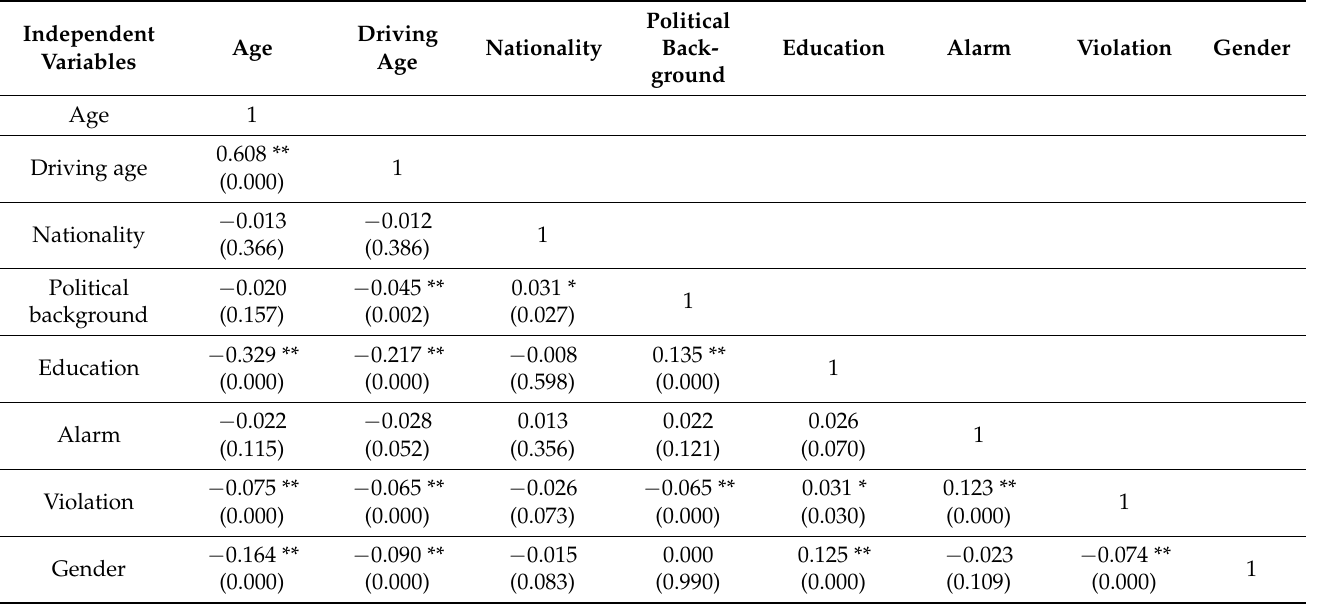
Table 10. Correlations of independent